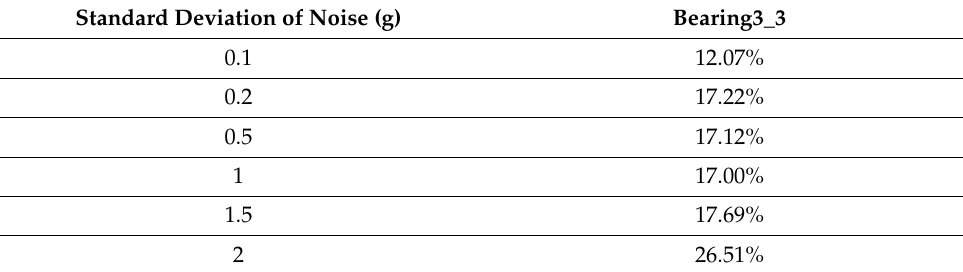
Table 4. RMSE prediction results under different noise levels.